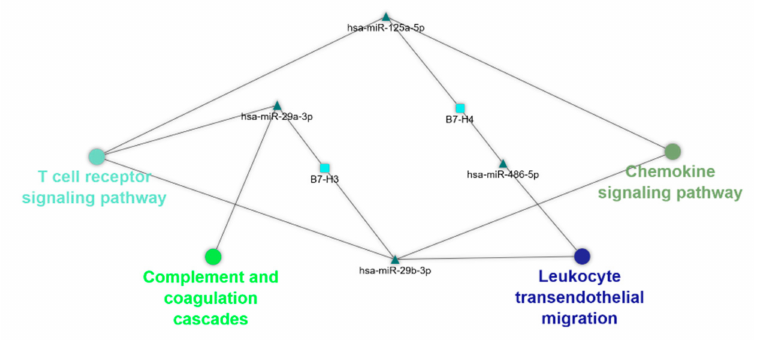
Figure 3. The predicted gene-miR-pathway network. Cytoscape v3.8.0 software was used for evaluating gene–miRNA interaction, and their corresponding immune-related pathways via their visualization as a network. Ellipse, triangle, and round rectangle represent pathway, miR, and gene,